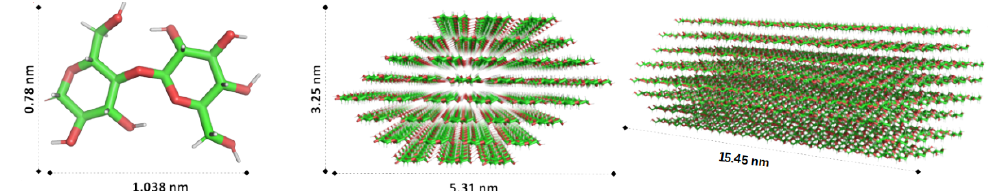
Figure 1. Left : Schematic representation of 1–4 linked I β cellulose molecular chain (color coding: carbon atoms are green, oxygen atoms are red, and hydrogen atoms are gray). Center and right : Two different views of a cellulose nanofibril (CNF) with 36 chains and 30 monomers per chain. The models were generated using the Cellulose Builder tool